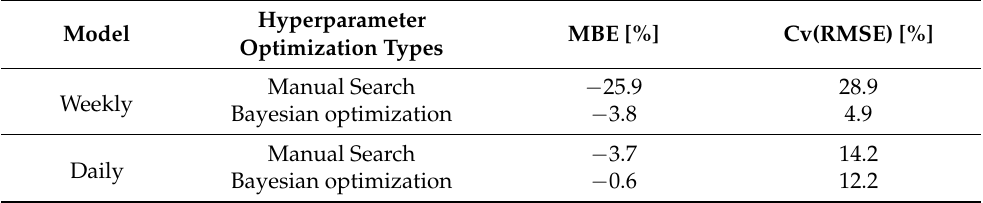
Figure 11. Load forecasting result with daily model and simulation data. Table 4. Error for test data with simulation data.